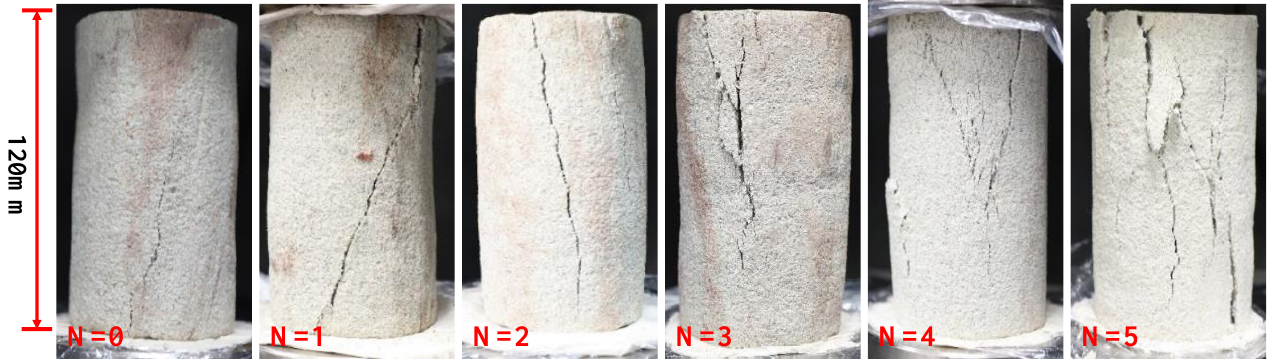
Figure 1. Failure modes of specimens at different wet – dry cycles.